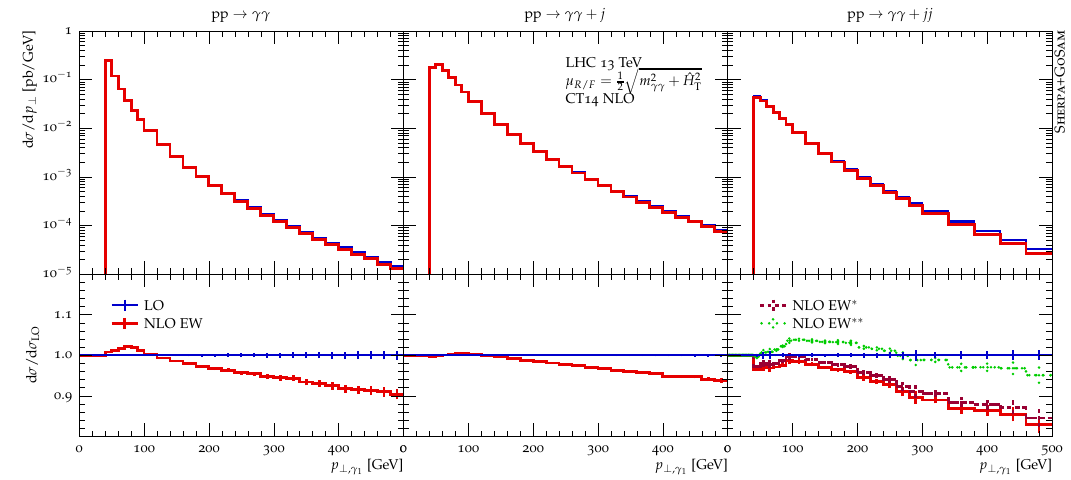
Figure 4 . The transverse momentum of the leading isolated photon in (cid:13)(cid:13) + 0 ; 1 ; 2 jets production at 13 TeV at the LHC.